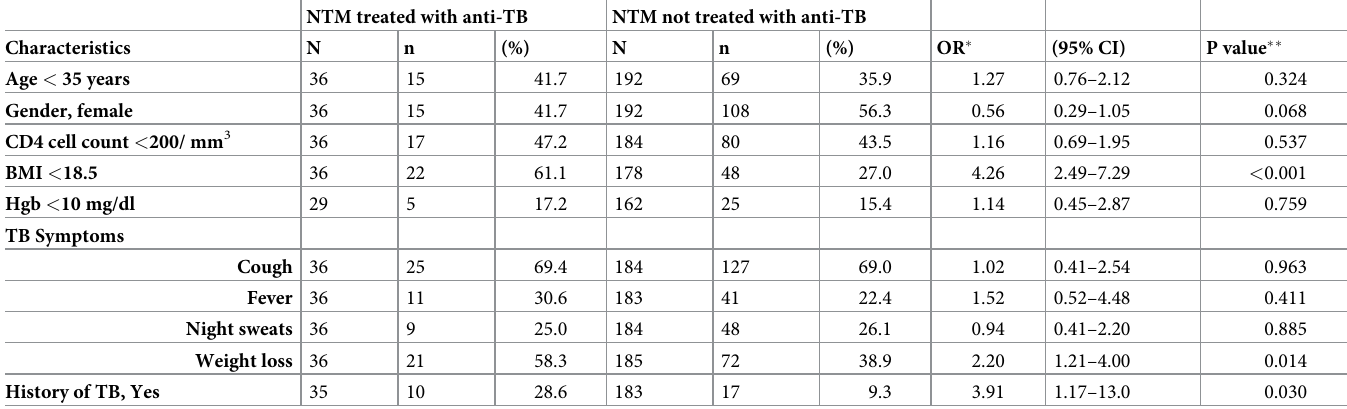
Table 4. Risk factors associated with increased likelihood of receiving anti-TB treatment among PLHIV with NTM. NTM treated with